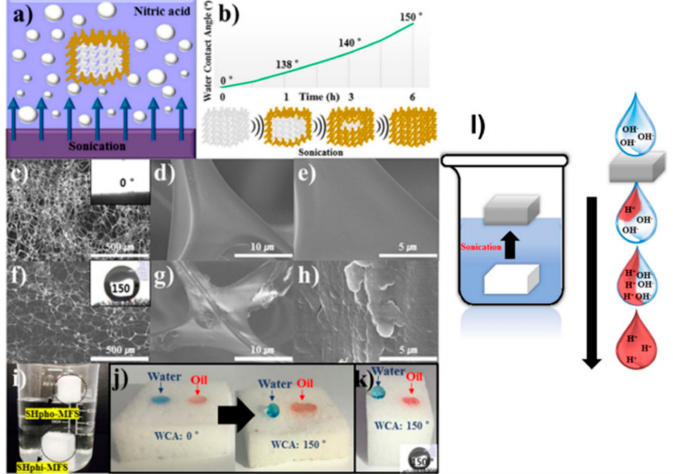
Figure 14. ( a )Schematicillustrationfortheswitchingofthesuperhydrophilic-MFStothesuperhydrophobic- MFSand( b )thewettabilitychangesofthesuperhydrophilic-MFS;( c – h )SEMimagesofthesuperhydrophilic- MFS( c – e )beforeand( f – h )afterultrasoundtreatment; ( i )imageshowingthesuperhydrophilic-MFS( bottom ) before and ( top ) after ultrasound treatment; ( j ) Water contact angles (WCAs) and oil contact angle (OCAs) on the superhydrophilic-MFS ( left ) before and ( right ) after ultrasound treatment; ( k ) WCA and OCA on the inside cross-sectional surface of superhydrophilic-MFS after ultrasound treatment; ( l ) schematic illustration for tuning a strong base into a tailored pH solution by a simple filtration. Reproduced with permission from [221]. Copyright 2019 Wiley-VCH Verlag GmbH & Co. KGaA, Weinheim.